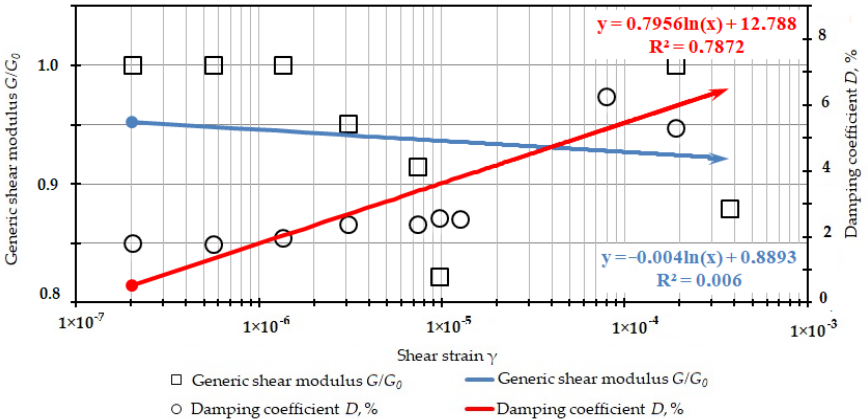
Figure A2. Graph of dependencies of generic shear modulus G/G 0 (unit fractions) and damping coefficient D (%) on the amplitude of shear strains γ (unit fractions) for cement stabilized soils. Test 2 (resonant column).